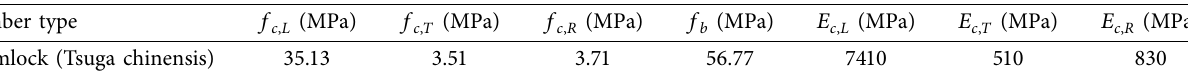
Table 5: Mechanical properties of